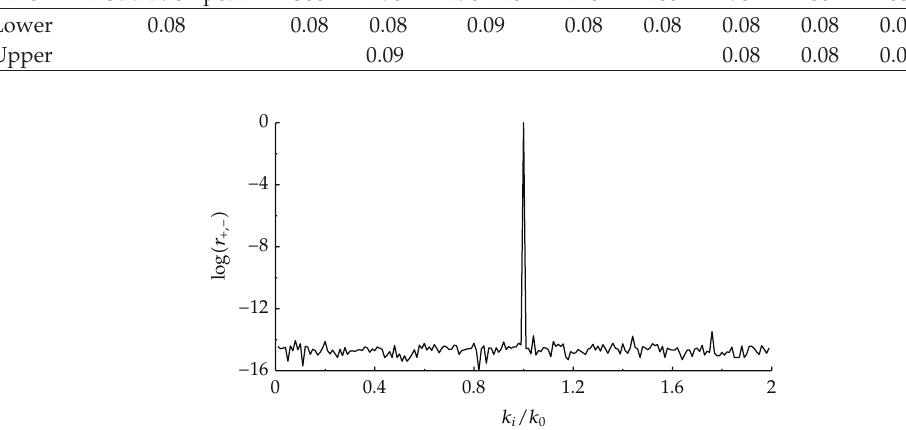
Figure 8: The Fourier spectra of the “un-seeded” initial wave system for case ε 0 (cid:7) 0 . 05.